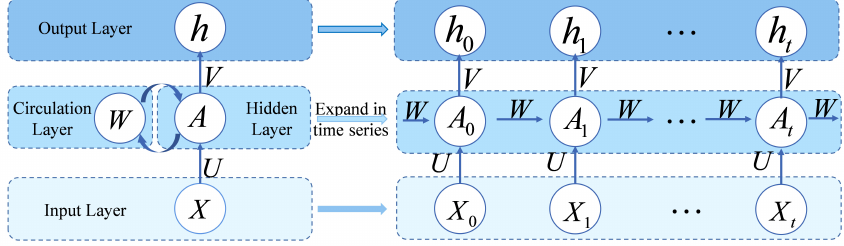
Figure 6. The structure of RNN.